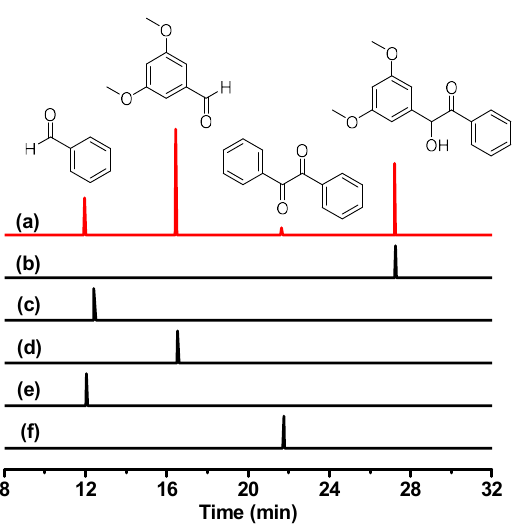
Figure 3. GC (gas chromatography) traces in MeCN of ( a ) DMB after 266 nm irradiation; ( b ) DMB; ( c ) benzoic acid; ( d ) 3,5-dimethoxybenzaldehyde; ( e ) benzaldehyde; ( f ) benzil.